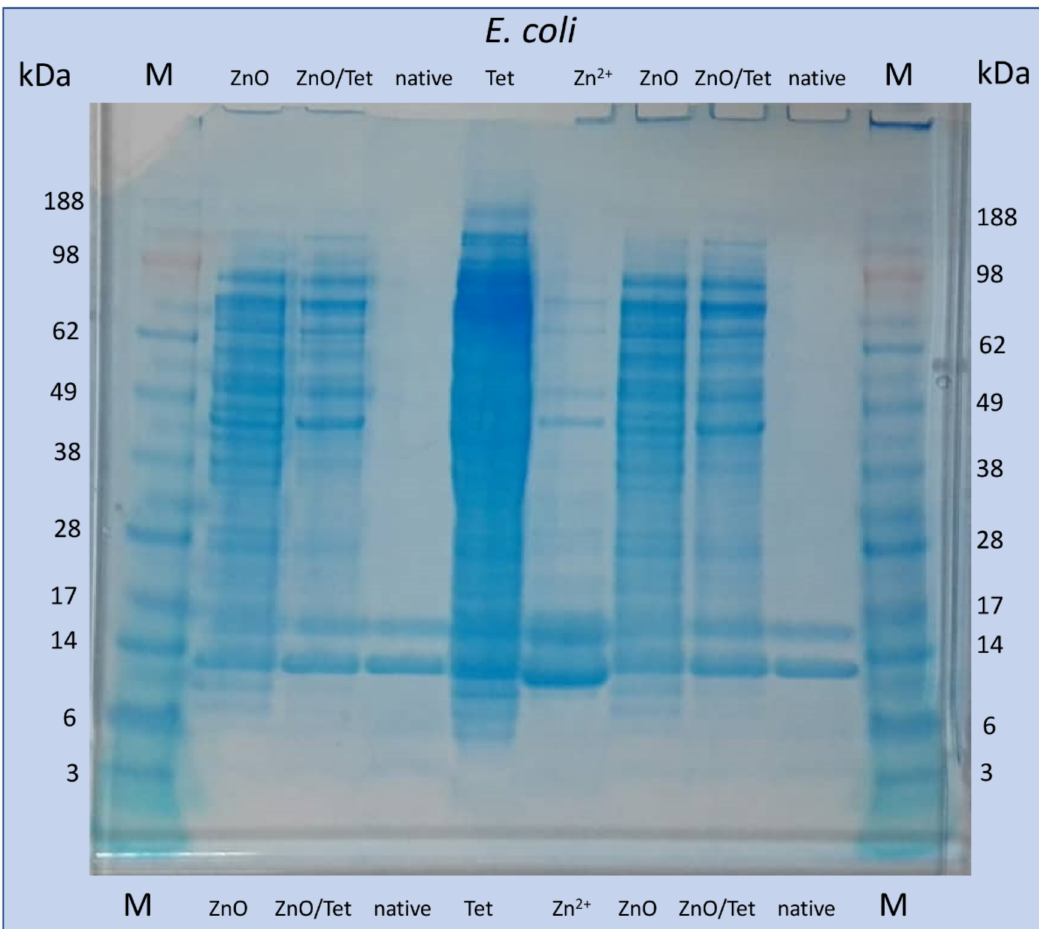
Figure 9. The picture of the gel after electrophoresis of proteins isolated from E. coli cells not treated (native) and treated with zinc oxide nanoparticles (ZnO), zinc ions (Zn 2+ ), tetracycline (Tet) and zinc oxide nanoparticles, functionalized with tetracycline (ZnO/Tet) and protein marker